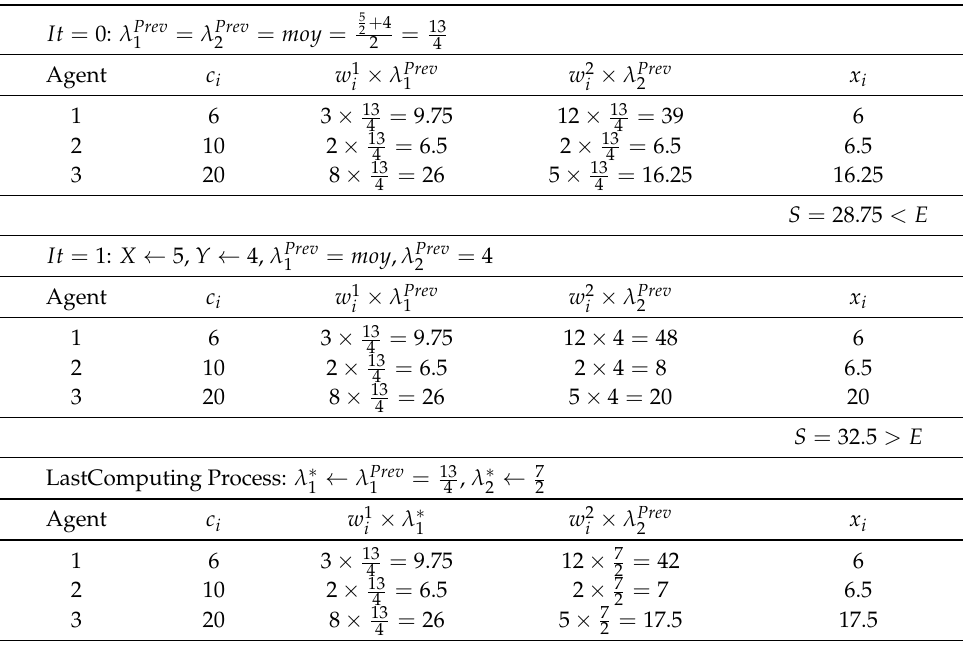
Table A1. Parameters computed at each the iteration It of Algorithm 1 on the